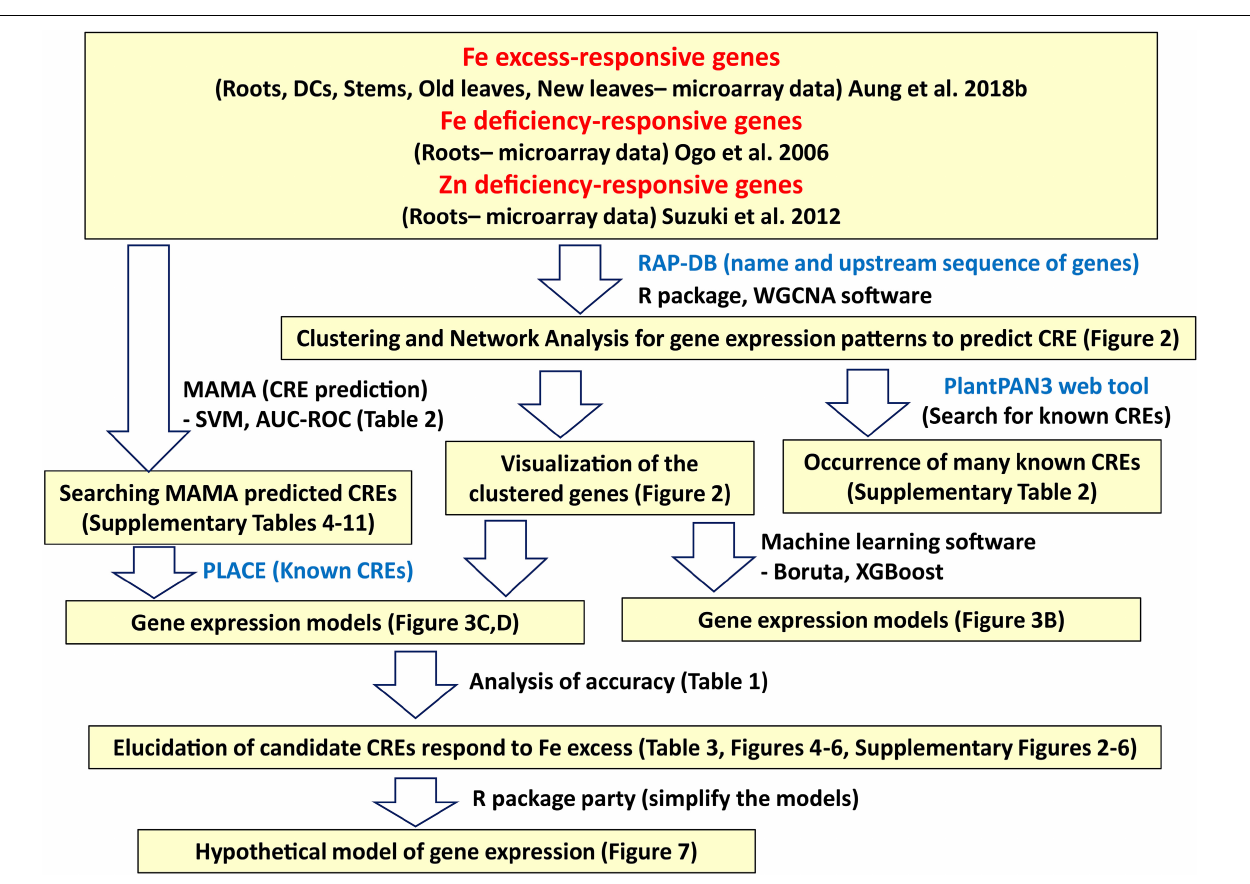
FIGURE 1 | Workflow for the discovery of Fe excess-responsive CREs. Description in the yellow hatched area indicates the data analyzed in each bioinformatics process. The software and methods used to produce bioinformatics data are shown to the right of the arrow.